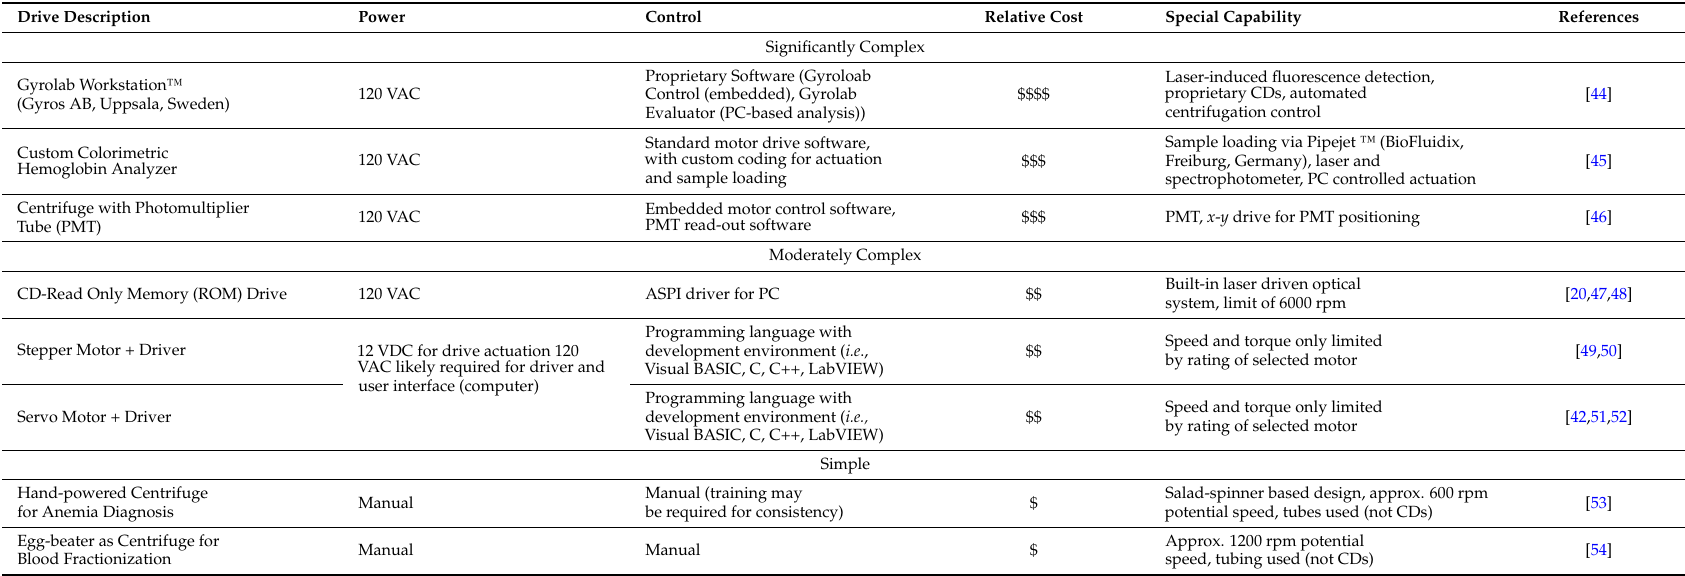
Table 1. Summary of CD drive